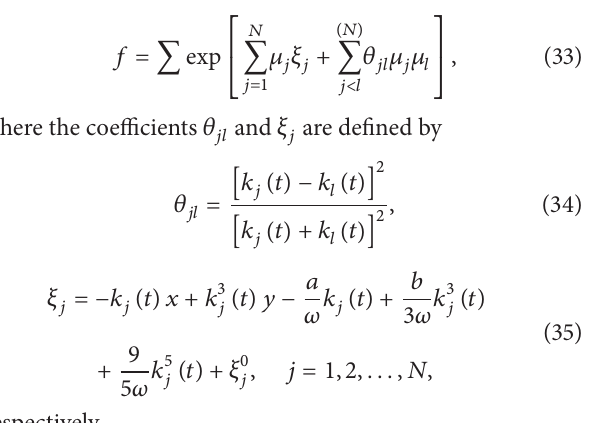
Figure 4: The density plots of two-soliton resonance for the nonisospectral GSK equation with parameters 𝜔 = −1 , 𝑎 = 1 , 𝑏 = 1 ,